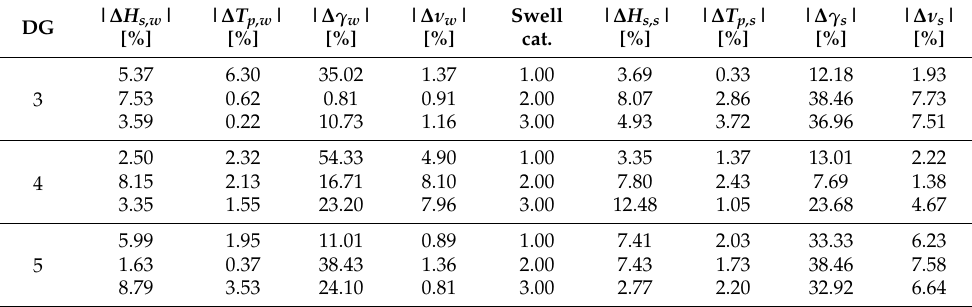
Table 8. Sea state assessment (Welch)—short duration and high frequency.